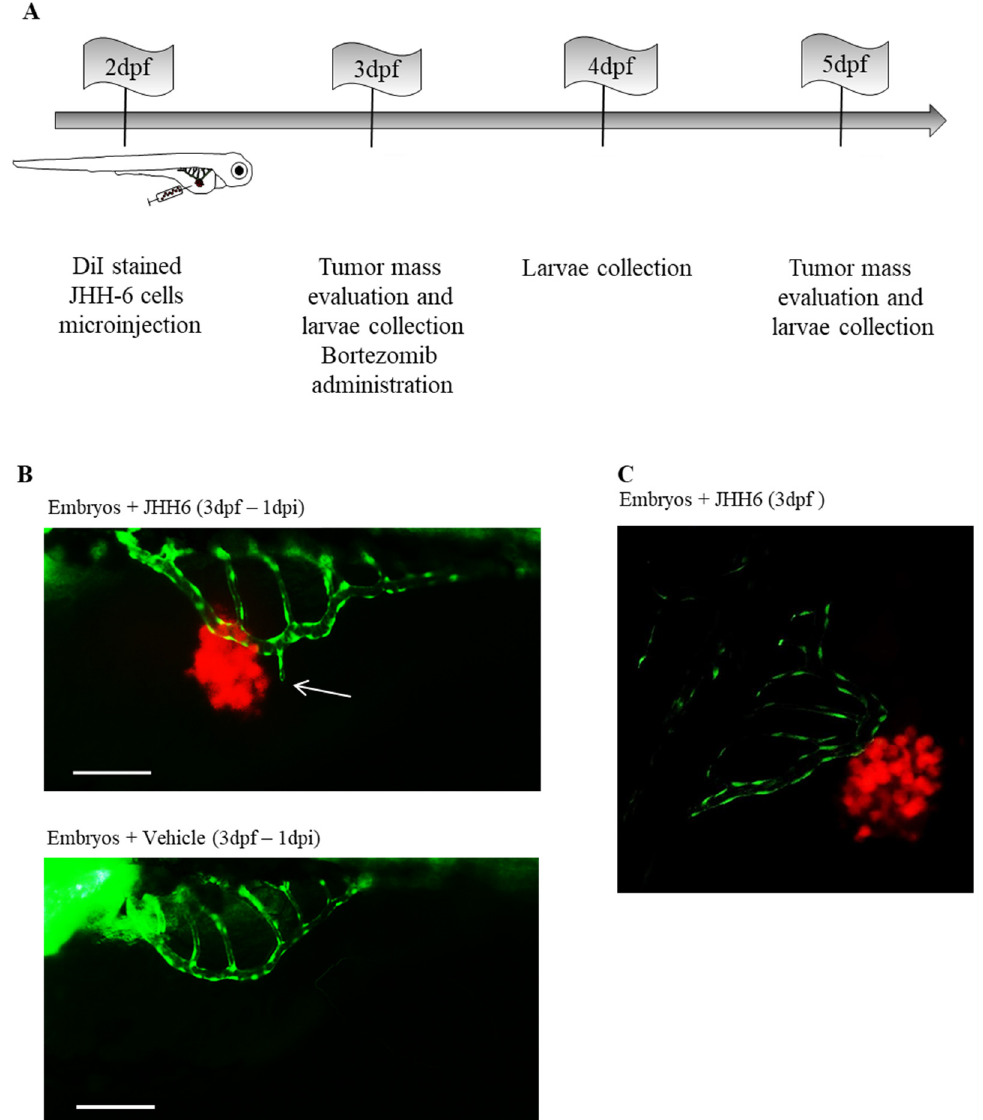
Figure 2. Neo-angiogenesis in zebrafish embryos microinjected with JHH6 cells. ( A ) Schematic representation of the protocol used to create the xenograft model of HCC in zebrafish embryos. DiI-stained JHH6 cells were microinjected into 2-dpf-old embryos’ yolk. Animals were then maintained at 34 ◦ C until the end of the experimental protocol (5 dpf). At 1 and 3 days post-tumor-cell-microinjection (1–3 dpi), images of the tumor masses were acquired by fluorescent microscope (Leica DM2000), and larvae were also collected to be analyzed. ( B ) Zebrafish neo-angiogenesis in larvae injected with JHH6 cells was examined by using the transgenic zebrafish strain Tg(fli1:EGFP). A representative zebrafish larva injected with stained JHH6 cells (red) is shown above. The image shows the vessels of the SIVP (green) near to the cancer cells (the white arrow shows a new branch of the SIVP); as control, a larva injected with vehicle alone is reported (bottom). Bar = 200 µ m, dpf = day(s) after fertilization; dpi = day(s) after injection, SIVP = Sub-Intestinal Vessels Plexus. ( C ) Representative JHH6 mass (red) and neo-vessels (green) imaged with a confocal microscope; bar = 200 µ m, dpf = day(s) post-fertilization; dpi = day(s) post-injection. ( B , C ) reproduced with permission from Reference [44]. Recently [45], a zebrafish carrying a loss-of-function point mutation in the acetyl- cholinesterase (ACHE) gene was used to generate a xenograft zebrafish model of HCC. ACHE is responsible for the enzymatic degradation of acetylcholine (ACh), and a decrease in its activity is positively associated with HCC tumor size and stage [76]. The genetically modified zebrafish strain (achesb55 − / − ) has a null phenotype with respect to ACHE function due to the point mutation. At 2 dpf, 300 Hep3B or SKHep1 cells stained